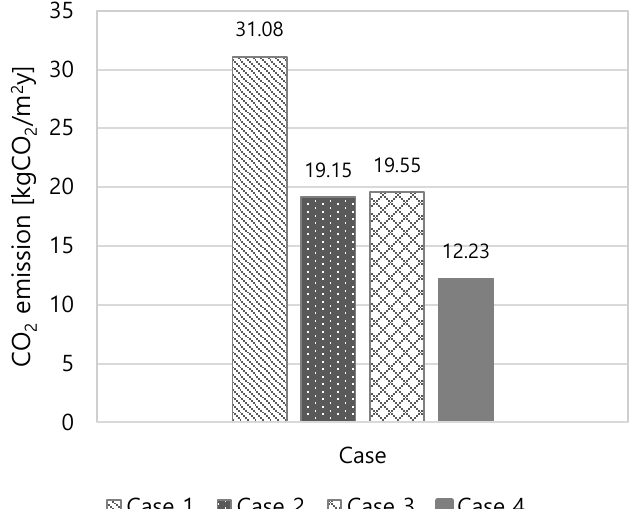
Figure 9. CO 2 emission of each case.